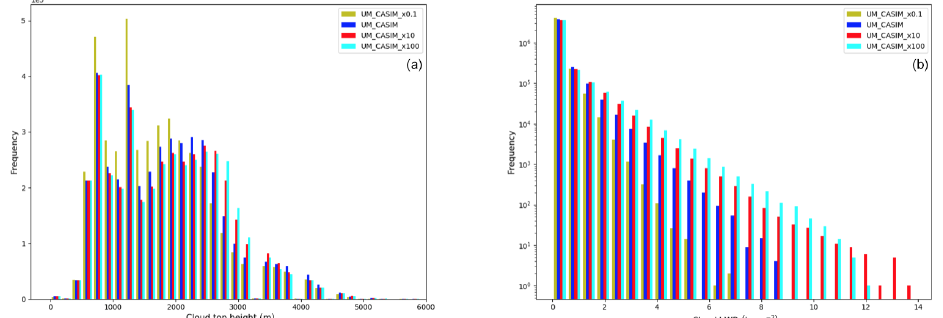
Figure 9. Histograms of cloud top height (a) , calculated as the highest cloudy grid box in a cloudy column, and of total column liquid water path (b) , calculated using only columns containing cloud.